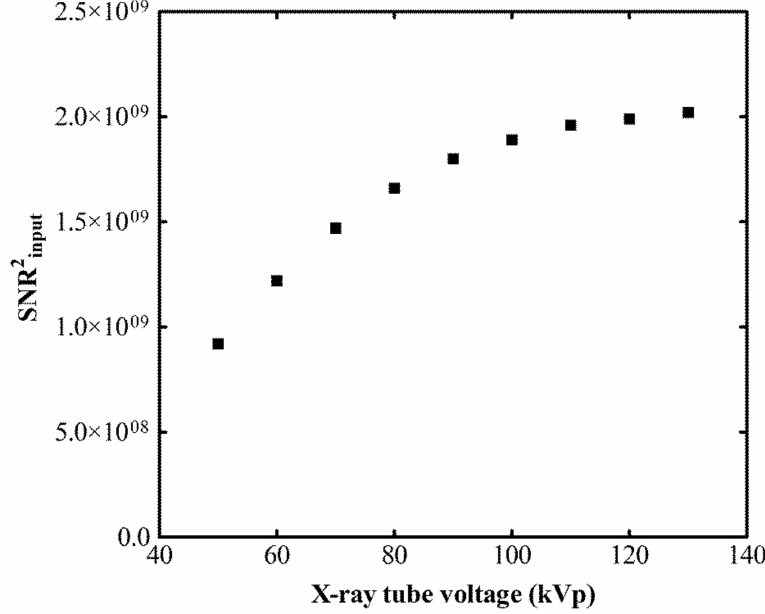
Figure 4. Signal-to-noise-ratio squared input as a function of tube